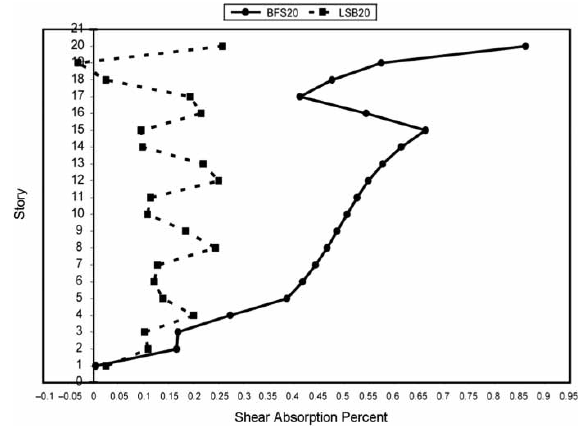
Fig. 19. Shear absorption percent of frame system in BFS20 and LSB20 models